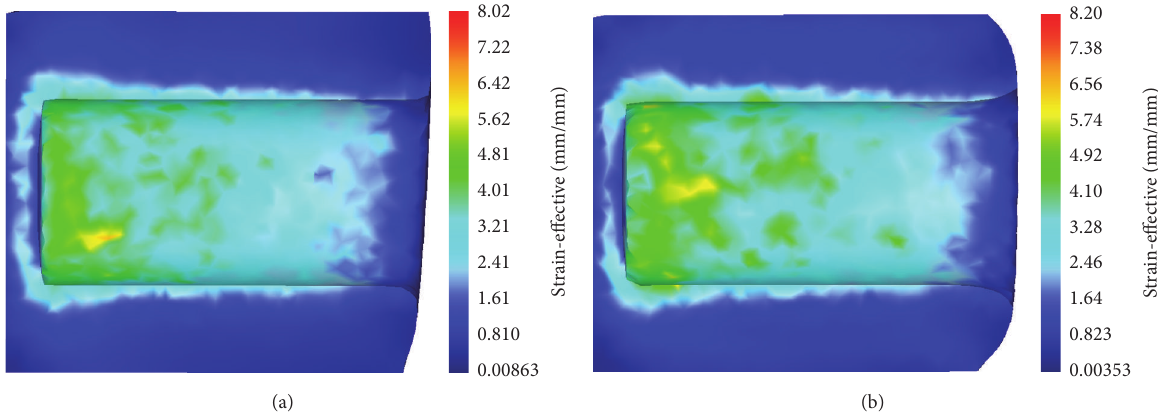
Figure 14: Strain field distribution of billet deformed at the friction coefficient of (a) 0.5 and (b) 0.7.